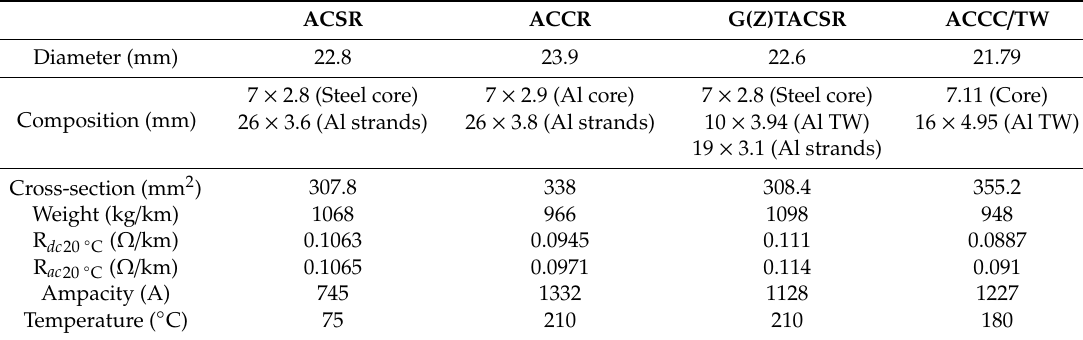
Figure 1. Main types of high temperature low sag (HTLS) conductors: ( a ) ACSR, ACSS; ( b ) ACCR, (Z)TACIR; ( c ) G(Z)TACSR; ( d ) ACCC/TW. Table 5. Comparison of the main HTLS conductor types with ACSR.